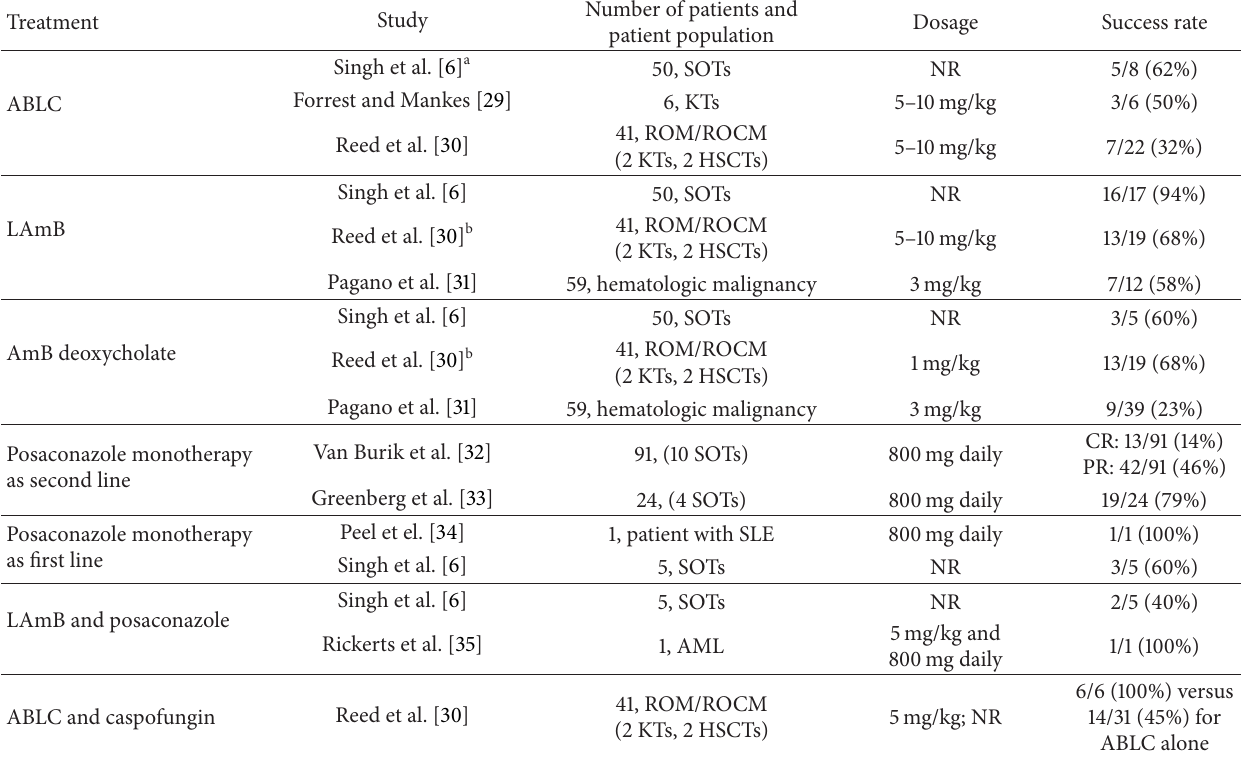
Table 1: Success rate of antifungal agents used to treat mucormycosis.